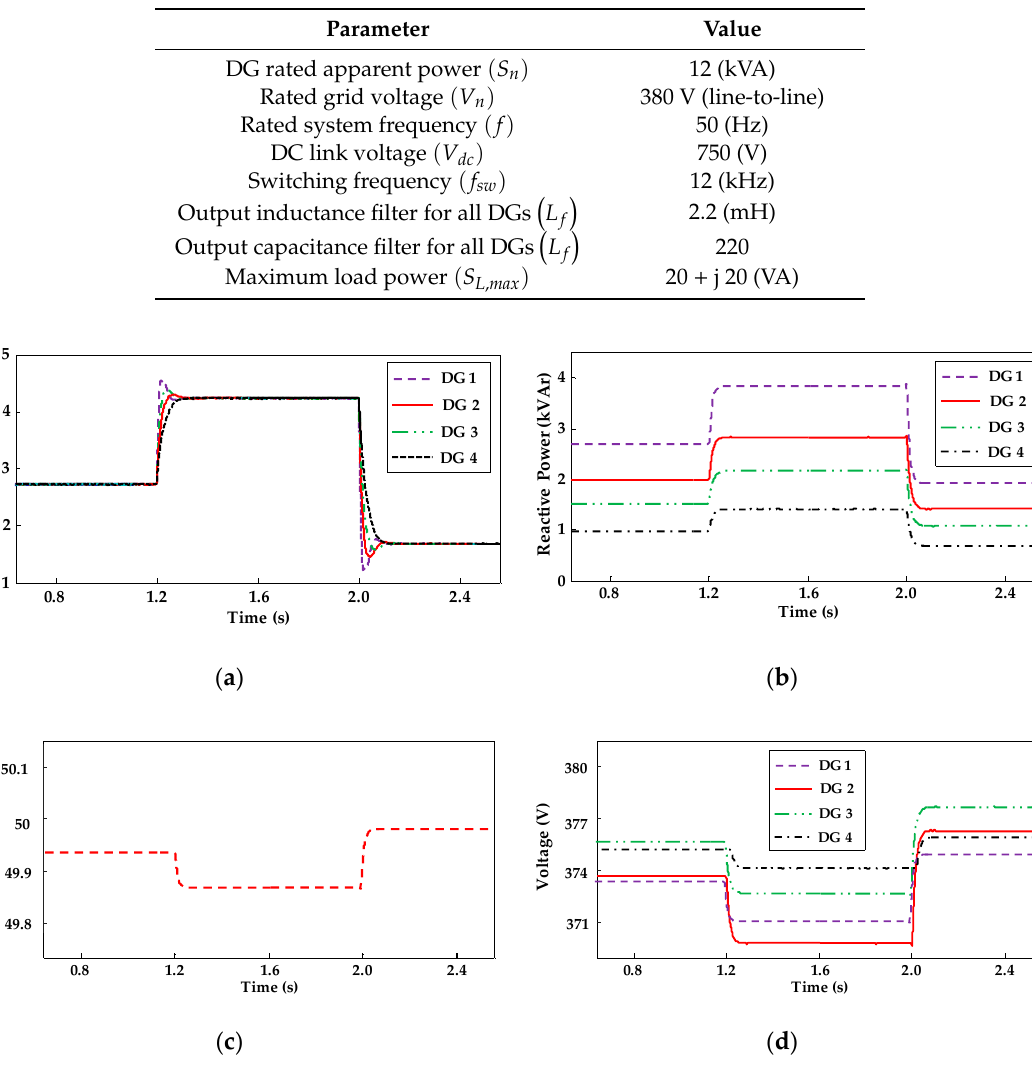
Figure 6. Scenario with proposed MSMC controller: ( a ) active power sharing; ( b ) reactive power sharing; ( c ) system frequency; ( d ) DGs terminal voltages.